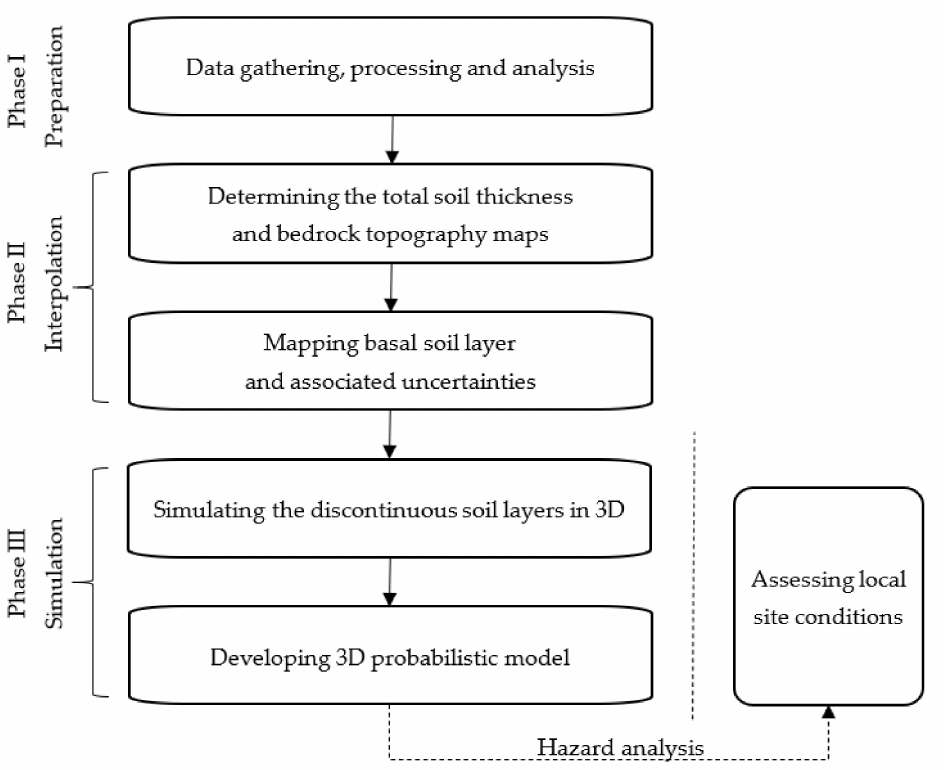
Figure 1. Methodology for developing a regional 3D probabilistic geological model.